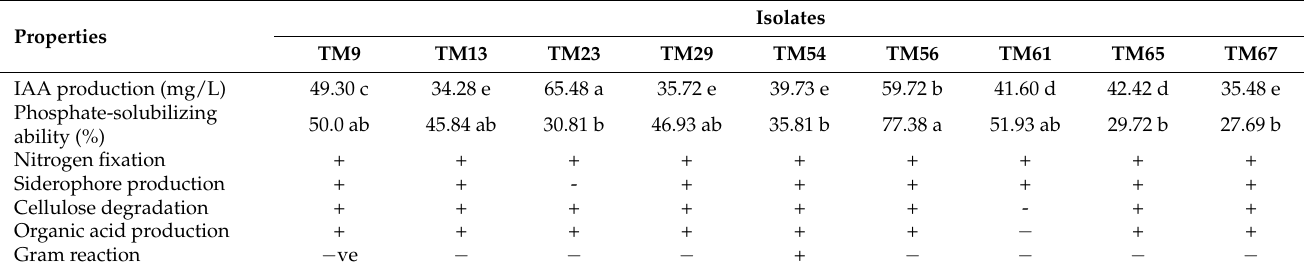
Table 6. Biochemical properties of Zn-solubilizing bacteria.